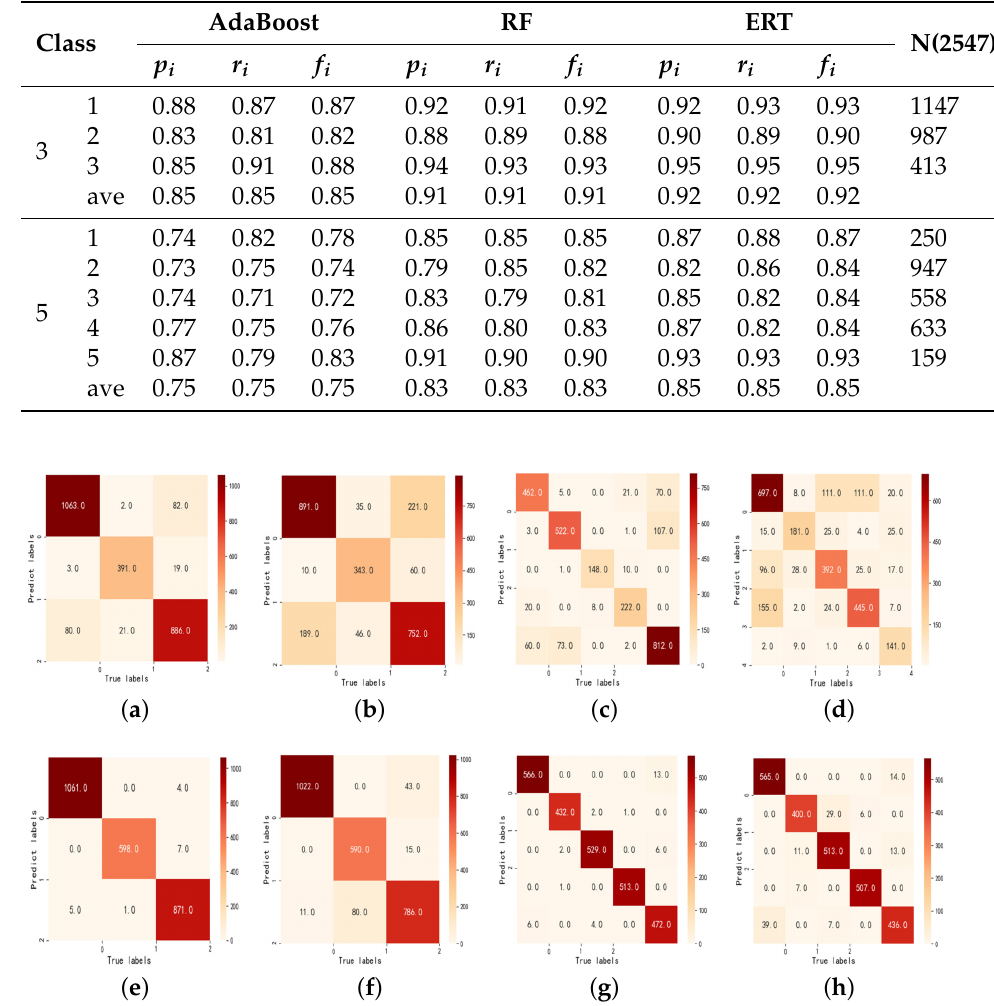
Table 5. The statistical performance of ERT for the torque prediction.